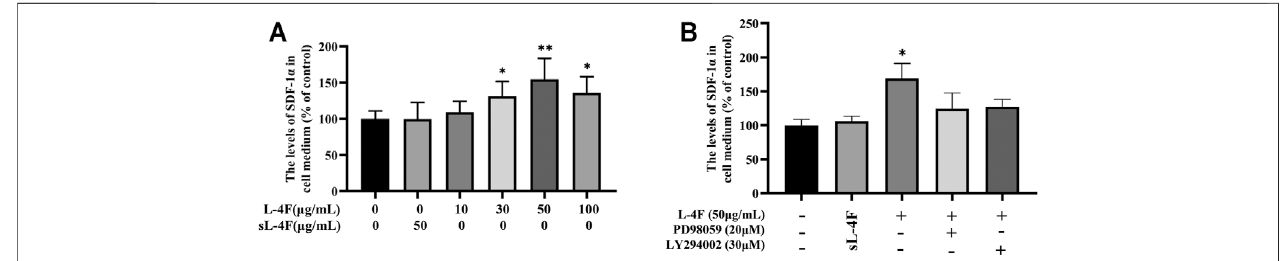
FIGURE 4 | L-4F upregulates the protein levels of SDF-1 α in HUVECs. (A) Cells were treated for 24 h with L-4F at various concentrations ( fi nal concentration at 0, 10, 30, 50, and 100 μ g/ml, respectively) or sL-4F at 50 μ g/ml ( n (cid:1) 6, one-way ANOVA, Dunnett ’ s test). (B) Cells were pretreated with and without relevant speci fi c inhibitors for 2 h prior to the treatment with L-4F or sL-4F at 50 μ g/ml for 24 h ( n (cid:1) 6, SNK test). * p < 0.05, ** p < 0.01, compared with control.